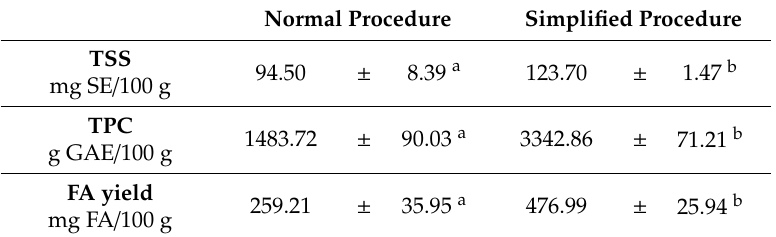
Table 6. Comparison of the results obtained for normal and simplified procedures applied after alkaline hydrolysis. TSS is expressed as mg of sucrose equivalent per 100 g of BSG, TPC is expressed as gram of gallic acid equivalent per 100 g of BSG, and FA yield is expressed as mg of FA per 100 g of BSG. Normal Procedure Simplified Procedure TSS 94.50